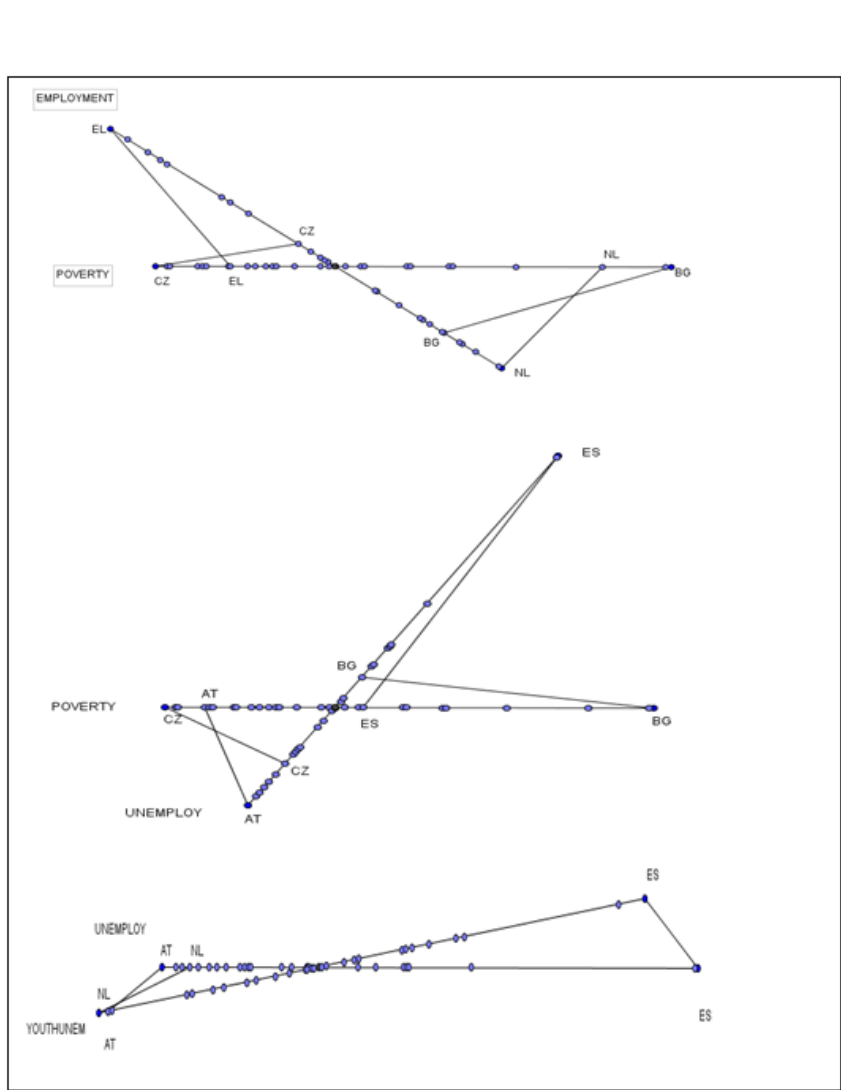
Figure 2 – Swallow-tail plots for three pair of variables with different r